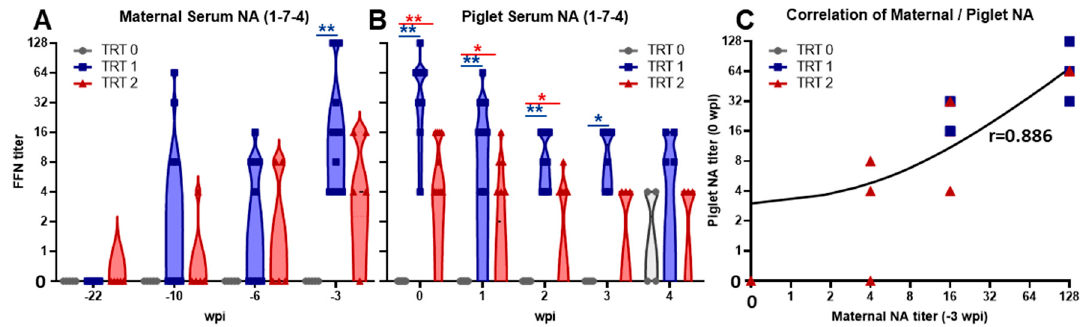
Figure 3. Autogenous inactivated boost vaccinations induce homologous neutralizing antibodies that are transferred to piglets. ( A ) Maternal serum neutralizing antibody (NA) titers to the homologous 1-7-4 strain after vaccination. ( B ) Piglet serum NA titers to 1-7-4 prior to inoculation (0 weeks post inoculation, wpi) and weekly after inoculation. ( C ) Pearson correlation matrix for maternal and piglet NA titers to 1-7-4 at -3 and 0 wpi, respectively. Data were analyzed via repeated-measures two-way ANOVA with Dunnett’s multiple comparisons. Significant differences are shown between treatments and within time point; they are designated as ** p < 0.01 and * p < 0.05.